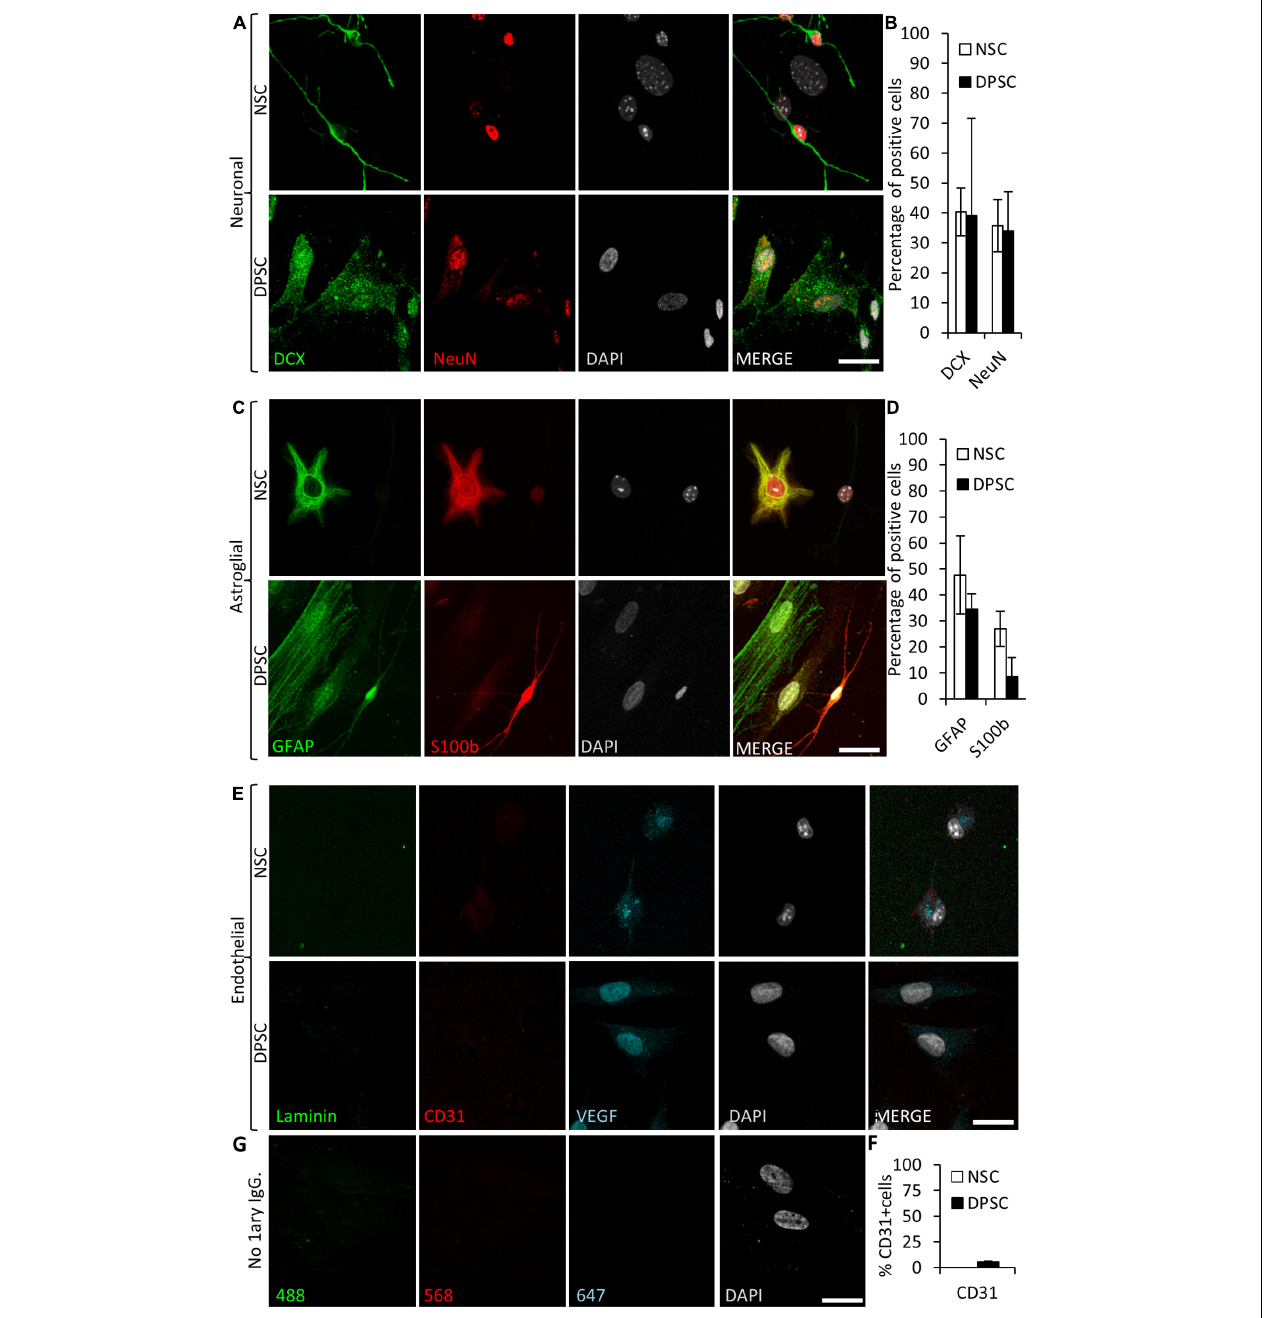
FIGURE 6 | Human DPSCs are able to commit toward differentiation to neuronal-like and glial-like lineages. One week of culture of both human DPSCs and murine (control) NSCs in Neurocult differentiation media is sufficient to induce them express markers for (A) neuronal lineage differentiation: doublecortin (DCX) and NeuN staining, for immature and mature neurons, respectively, and (C) Astroglial lineage differentiation: glial fibrillary acidic protein (GFAP) and S-100 β immunostaining, for immature and mature astrocytes, respectively. (B,D) Graphs showing quantifications (mean ± SEM, n = 360 cells) of three independent experiments. (E) After 1 week of growth in neural differentiation conditions, both NSCs and DPSCs still express VEGF but downregulate CD31. (F) Quantification of the proportion of CD31 positive cells ( n = 571). (G) Control with no 1 ary antibodies. Scale bar 20 µ